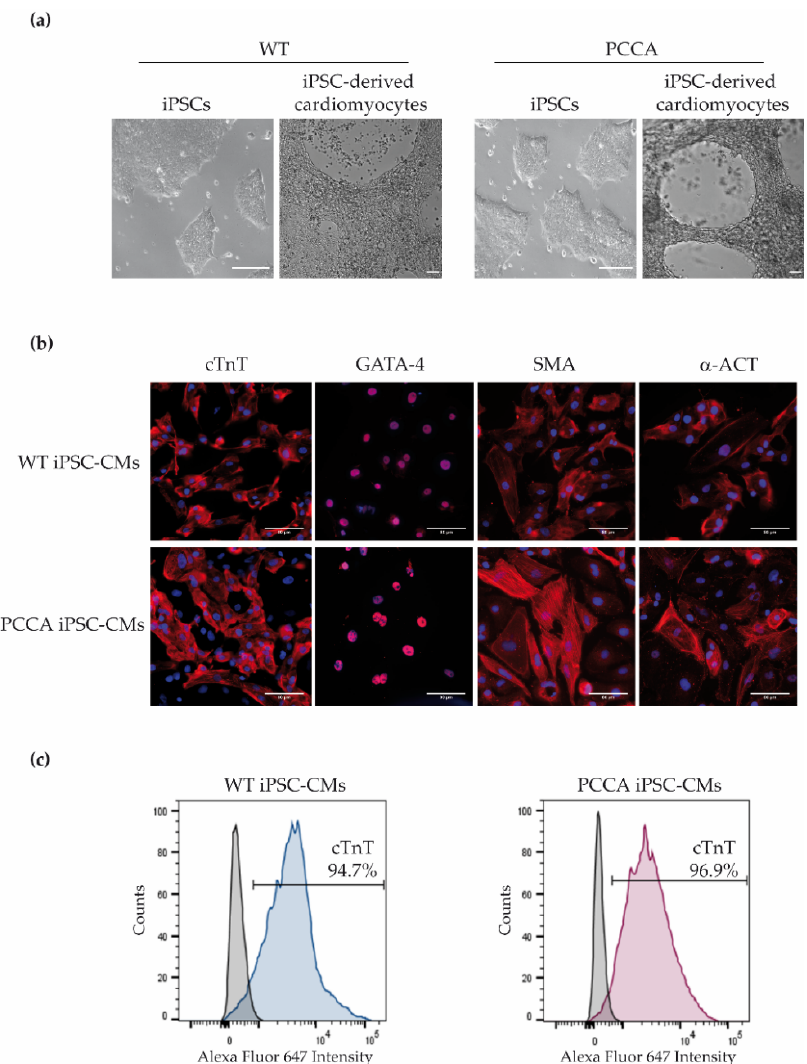
Figure 1. Phase-contrast pictures of iPSCs and differentiated cardiomyocytes and expression of cardiac markers in wild-type (WT) and PCCA iPSC-derived cardiomyocytes (iPSC-CMs). ( a ) Phase-contrast images of iPSC and iPSC-derived cardiomyocytes of WT and PCCA; scale bar: 100 µm. ( b ) Immunofluorescence analysis for cardiac troponin T (cTnT), GATA-4, α -smooth muscle actin (SMA) and α -actinin ( α -ACT) in iPSC-derived cardiomyocytes; scale bar: 80 µ m. ( c ) Flow cytometry analysis for cTnT cardiac marker. A representative experiment for cTnT expression is